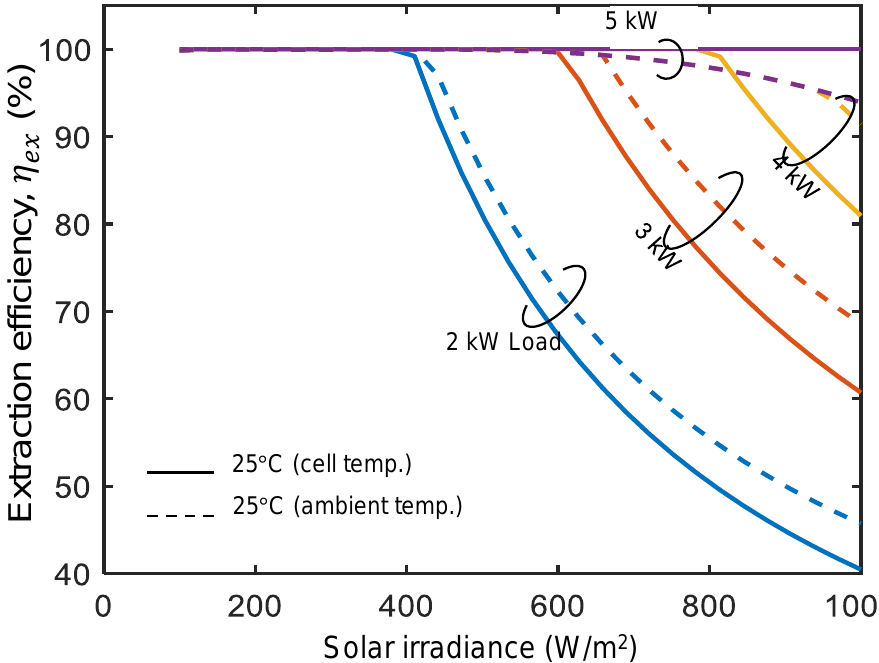
Figure 5. Solar energy extraction efficiency of the system for different load power under varying sunshine conditions. Load voltage is assumed to be 535 V DC